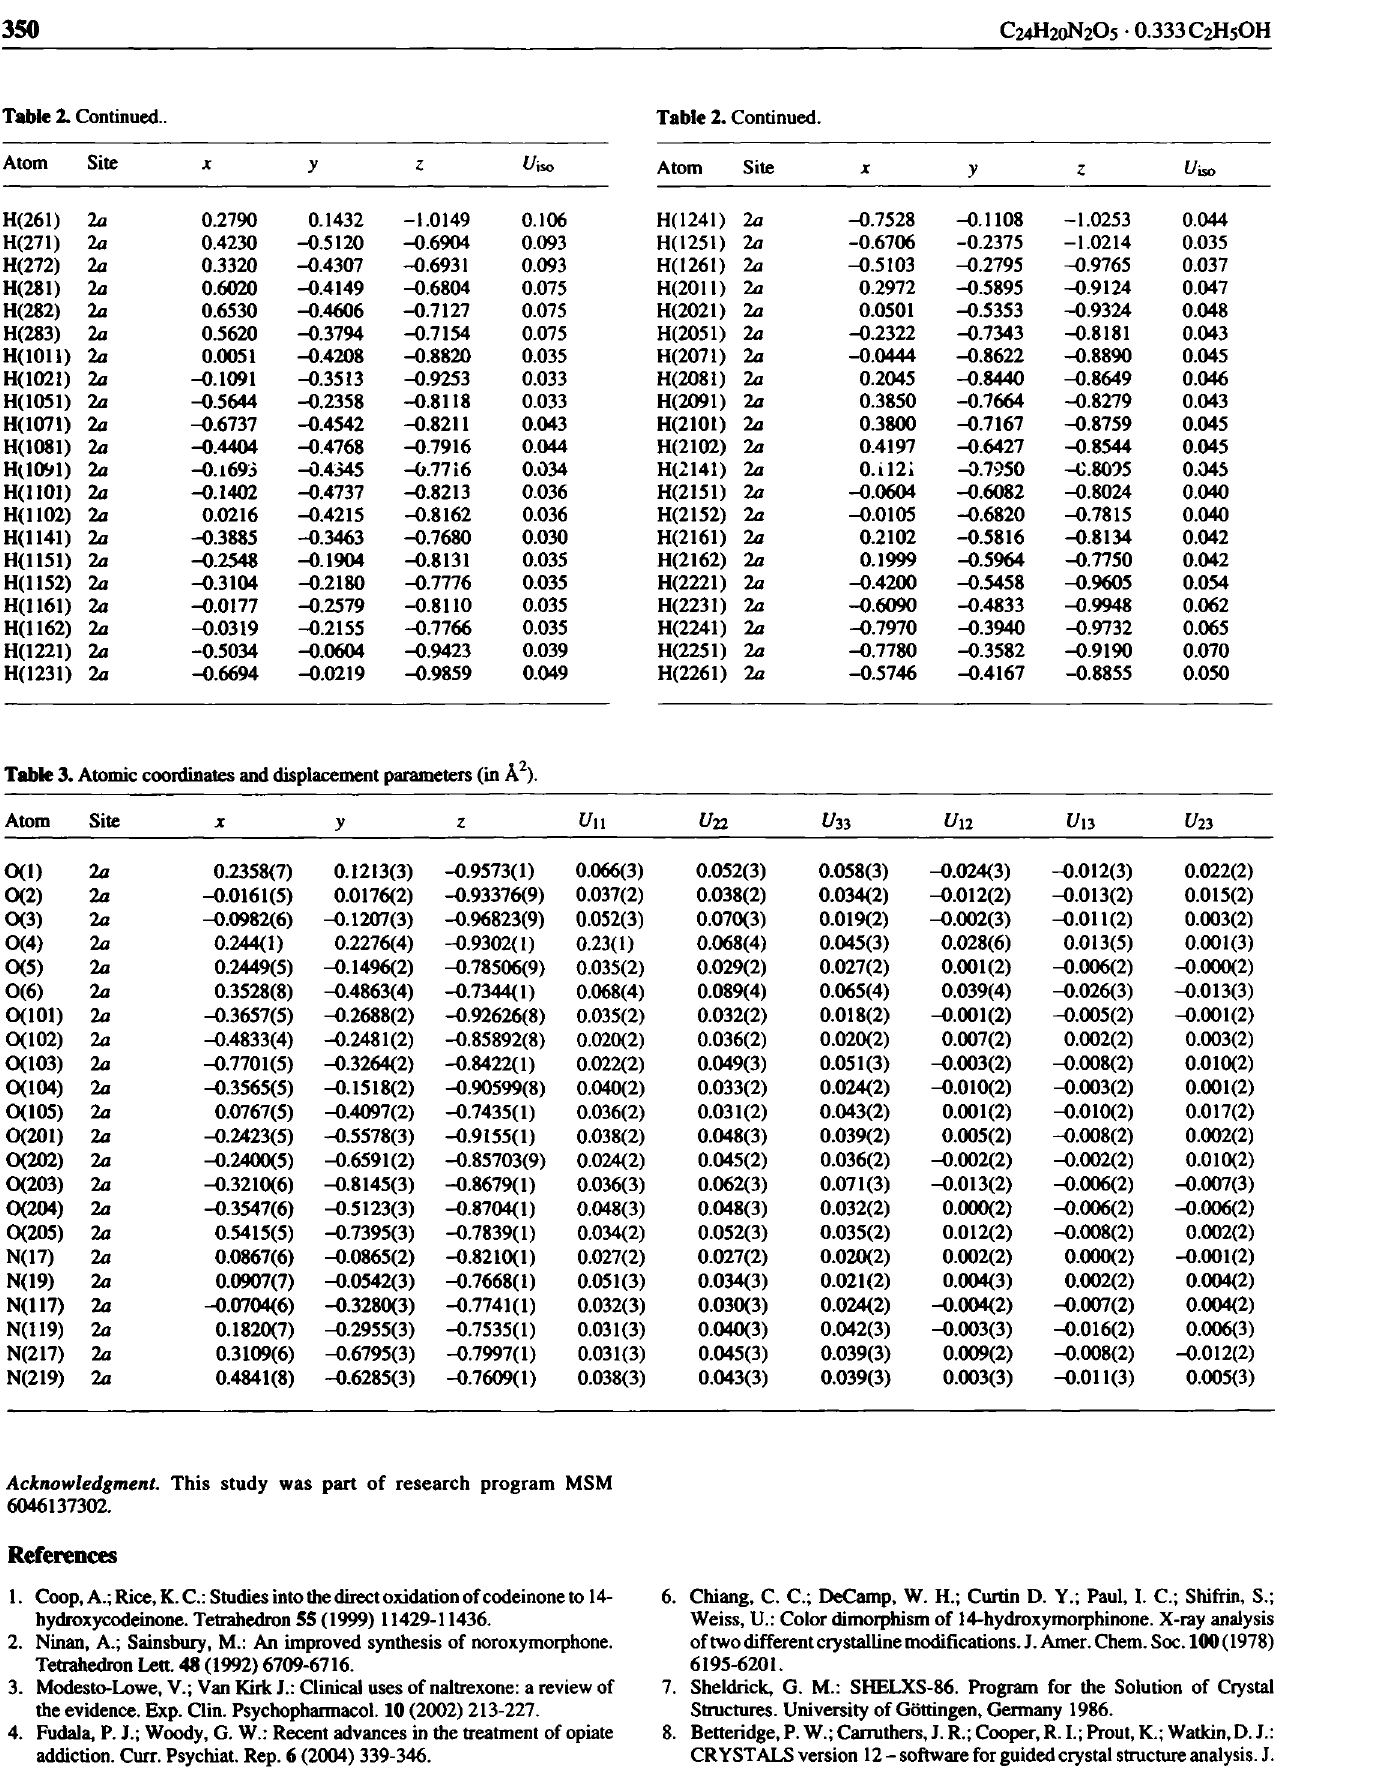
Table 3. Atomic coordinates and displacement parameters (in A 2